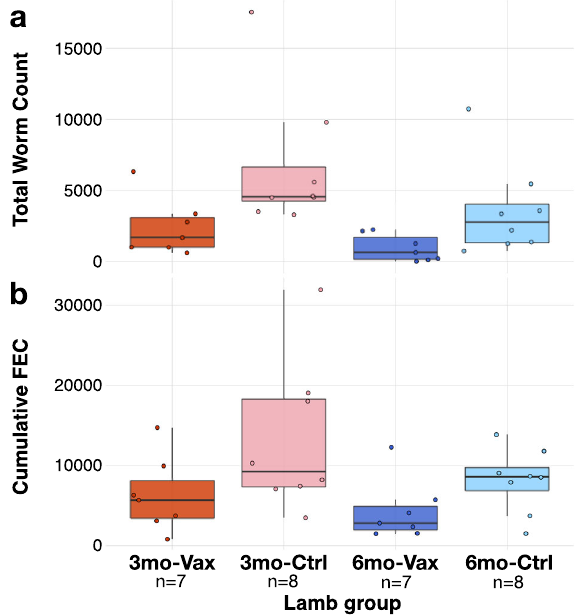
Fig. 1 Vaccine- and age-mediated control of T. circumcincta infection. a Worm burdens and ( b ) total egg output in 3 month- old lambs with vaccination (3mo-Vax), 3 month-old lambs with adjuvant only (3mo-Ctrl), 6 month-old lambs with vaccination (6mo- Vax), and 6 month-old lambs with adjuvant only (6mo-Ctrl). Immunisation with the prototype vaccine led to a median 73.7% reduction (P vacc = 0.002, GLM) in worm counts and 50% reduction (P vacc = 0.026, GLM) in cumulative egg